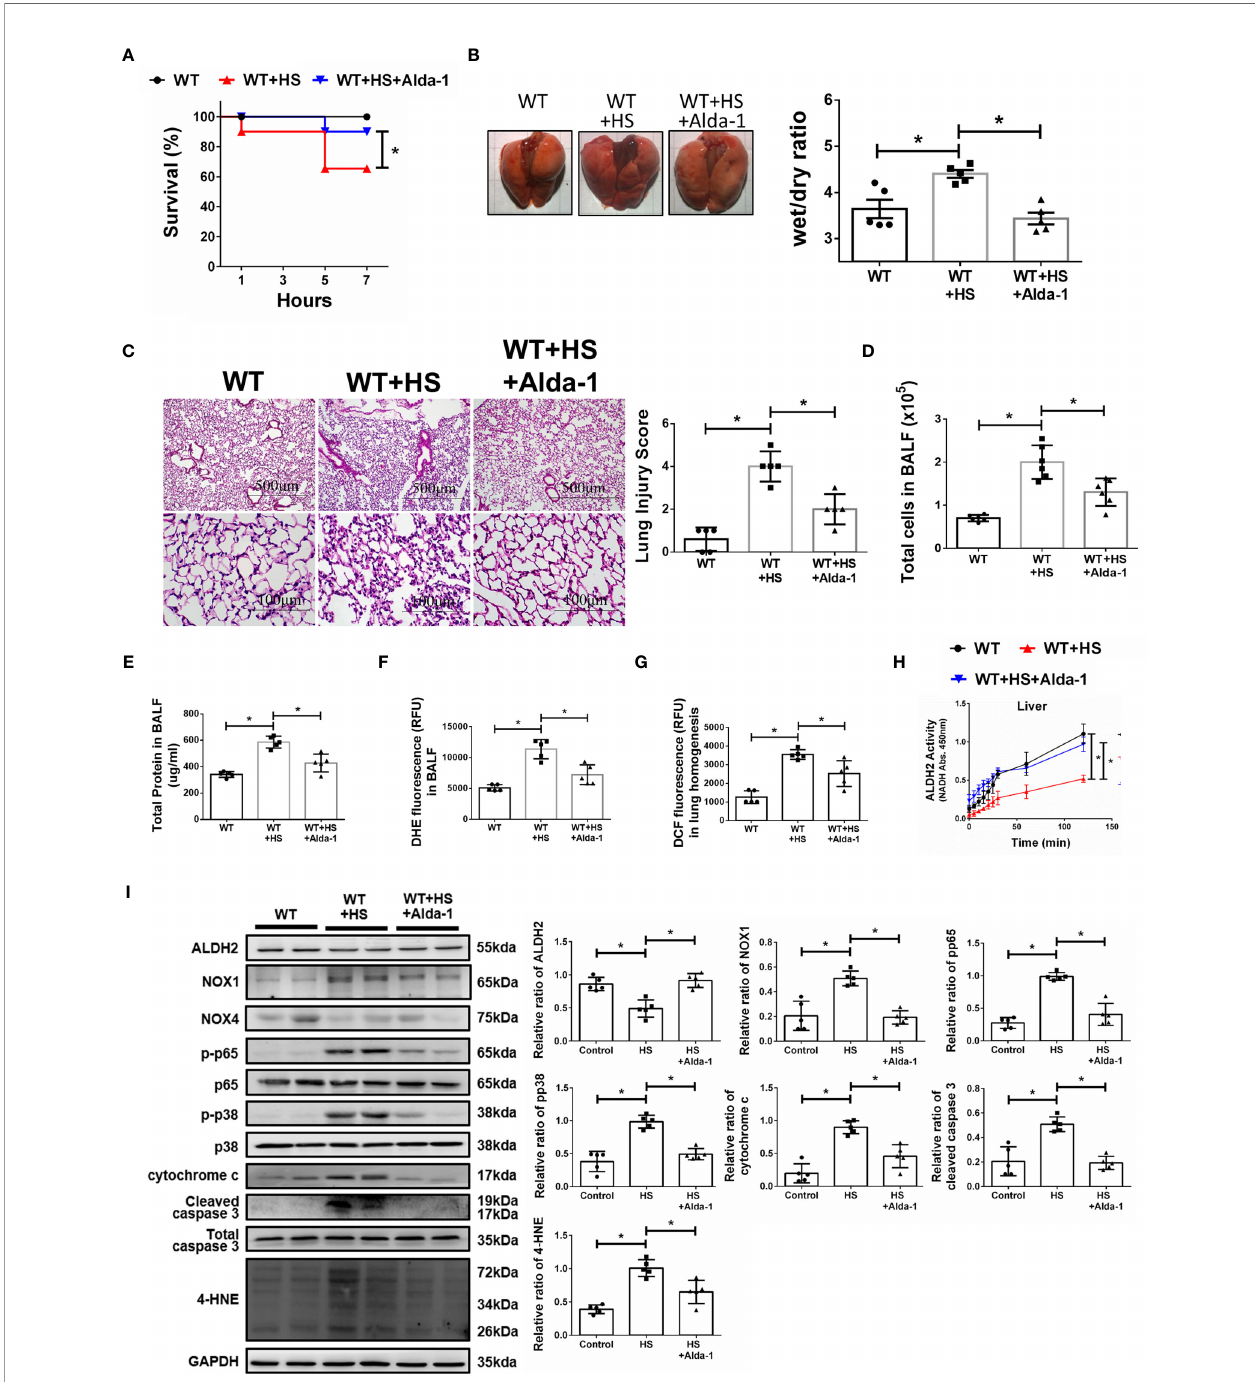
FIGURE 4 | Alda-1 attenuates HS-induced ALI in vivo. Alda-1-pretreated C57BL/6J mice were exposed to WBH (42°C, 80% RH for 1 h) and then analyzed. (A) Survival of mice subjected to WBH ( n = 20 in each group). (B) Representative images of the lungs and wet/dry ratio of the lungs ( n = 5). (C) H&E stain of the lungs ( n = 5). (D) Total cells in the BALF ( n = 5). (E) Total protein in the BALF ( n = 5). (F) Measurement of ROS production in BALF based on DHE fl uorescence as determined using a fl uorescence microplate reader with an excitation wavelength of 518 nm and an emission wavelength of 606 nm ( n = 5). (G) Measurement of ROS production in lung homogenates based on DCF fl uorescence as determined using a fl uorescence microplate reader with an excitation wavelength of 488 nm and an emission wavelength of 535 nm ( n = 5). (H) The ALDH2 activity in lung homogenates was measured by NADH production based on the O.D. absorbance at 450 nm in a microplate reader ( n = 5). (I) The protein and 4-HNE levels in lung homogenates were measured by immunoblotting. Densitometric analysis was conducted with imaging processing software. The data were quanti fi ed by normalization to GAPDH; phosphorylated proteins were normalized to total proteins ( n = 5). The data are expressed as the mean ± SD. Statistical signi fi cance is indicated as * p <